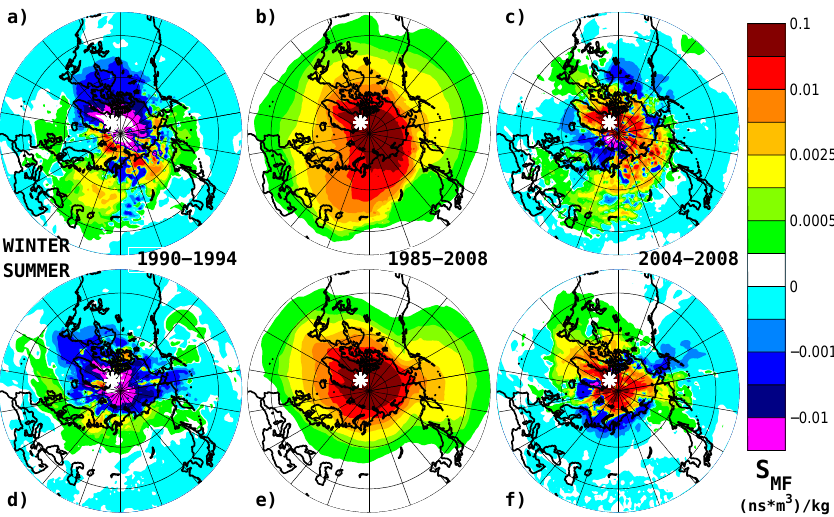
Fig. 2. Transport climatologies ( S MF ) at Alert during winter (upper row of panels) and summer (lower row). The middle column shows the mean S MF , averaged over the whole time period (1985–2008). The left column of panels illustrates the difference from the mean flow for the early period 1990–1994, and the right column illustrates the difference from the mean for the late period 2004–2008. The station’s location is marked with a white asterisk.